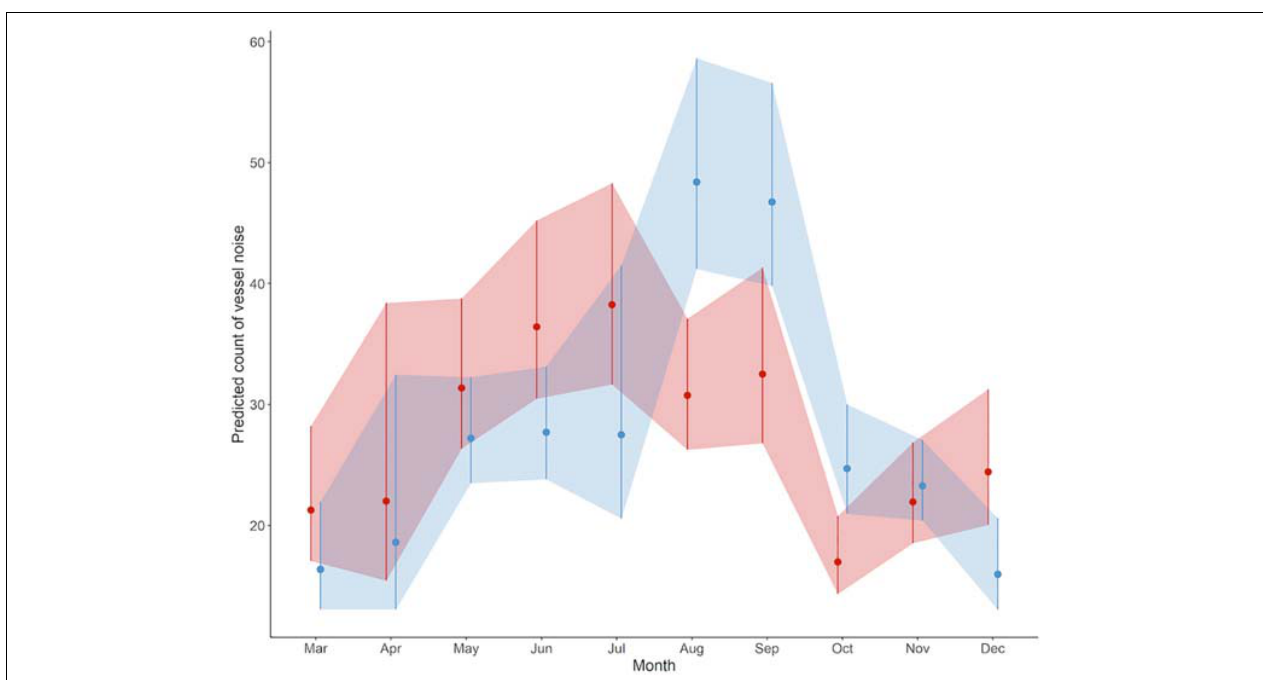
FIGURE 6 | Daily counts of vessel noise occurrence during each month predicted by the gamma regression model. Color denotes sites (Site A: red, Site B: blue). Points represent values ( ± SD shaded region) predicted by the regression